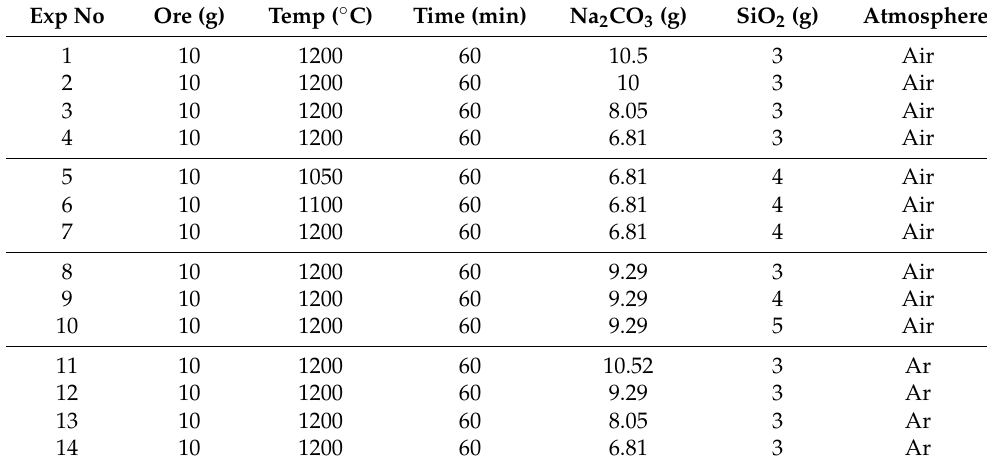
Table 2. Experimental conditions for high-temperature processing of wolframite concentrate. Exp No Ore